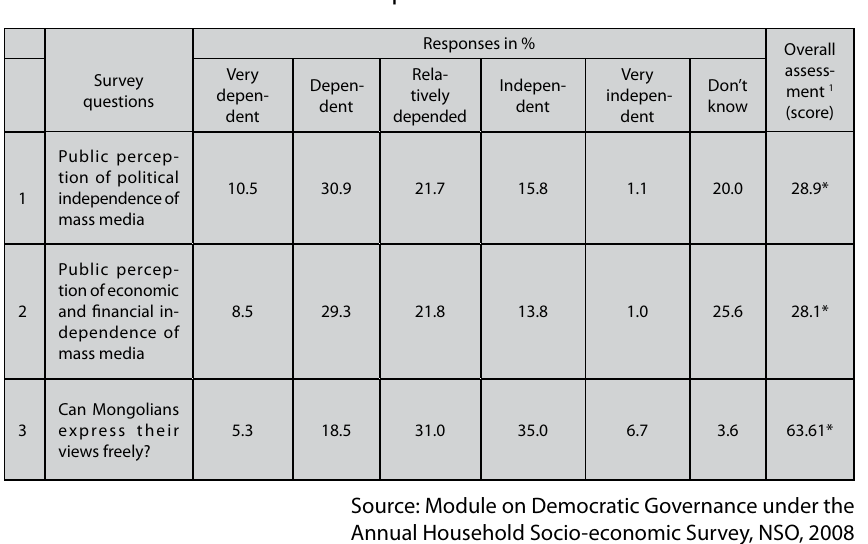
Table 3. Public Perception of Political,